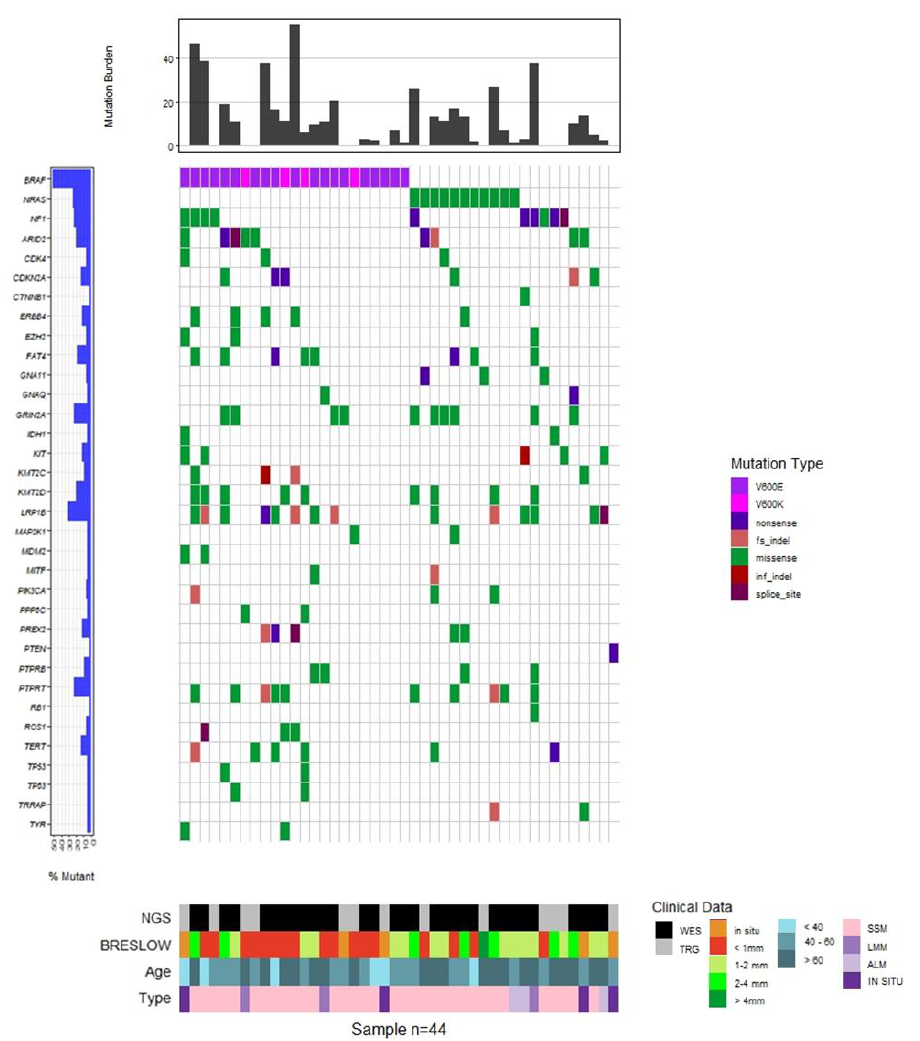
Figure 3. Oncoplot of somatic variance distribution in the melanoma patients under investigation. The top 20 cancer-related genes from COSMIC and additional 14 genes targeted by the Oncomine melanoma panel are shown (total = 34 genes), carrying at least one variant. The bar plot at the top of the figure displays the tumour mutation burden (TMB) for the samples analysed by WES. The observed frequency of mutations for each gene is presented at the left. Clinical data are shown: Breslow thickness, age group at melanoma diagnosis, and type of histological characterisation (SSM: Superficial Spreading Melanoma; ALM: Acral Lentiginous Melanoma; LMM: Lentigo Maligna Melanoma; IN SITU) and the sequencing technology applied (WES: Whole Exome Sequencing and TRG: Targeted Sequencing).